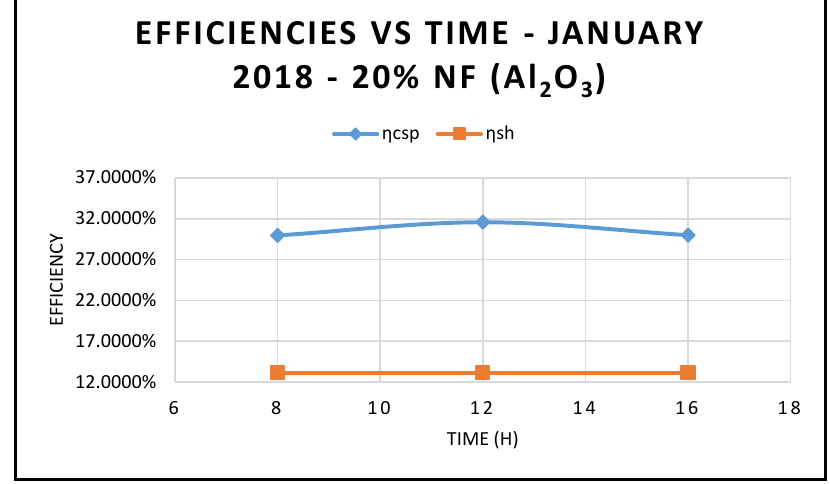
Figure 10. Efficiencies of the CSP collector and hybrid system at a concentration of 20% Al 2 O 3.